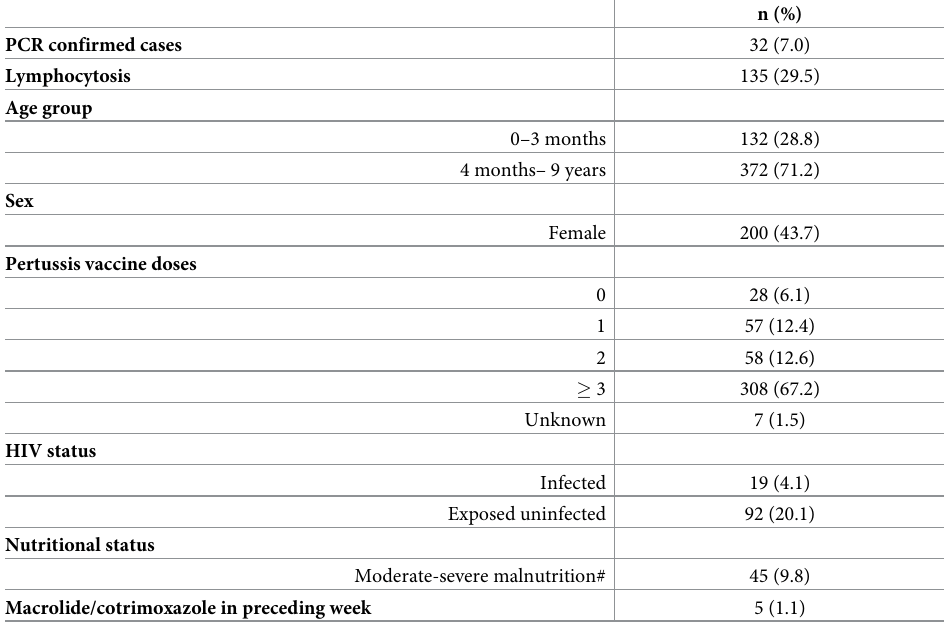
Table 2. Baseline characteristics of study participants (N = 458).